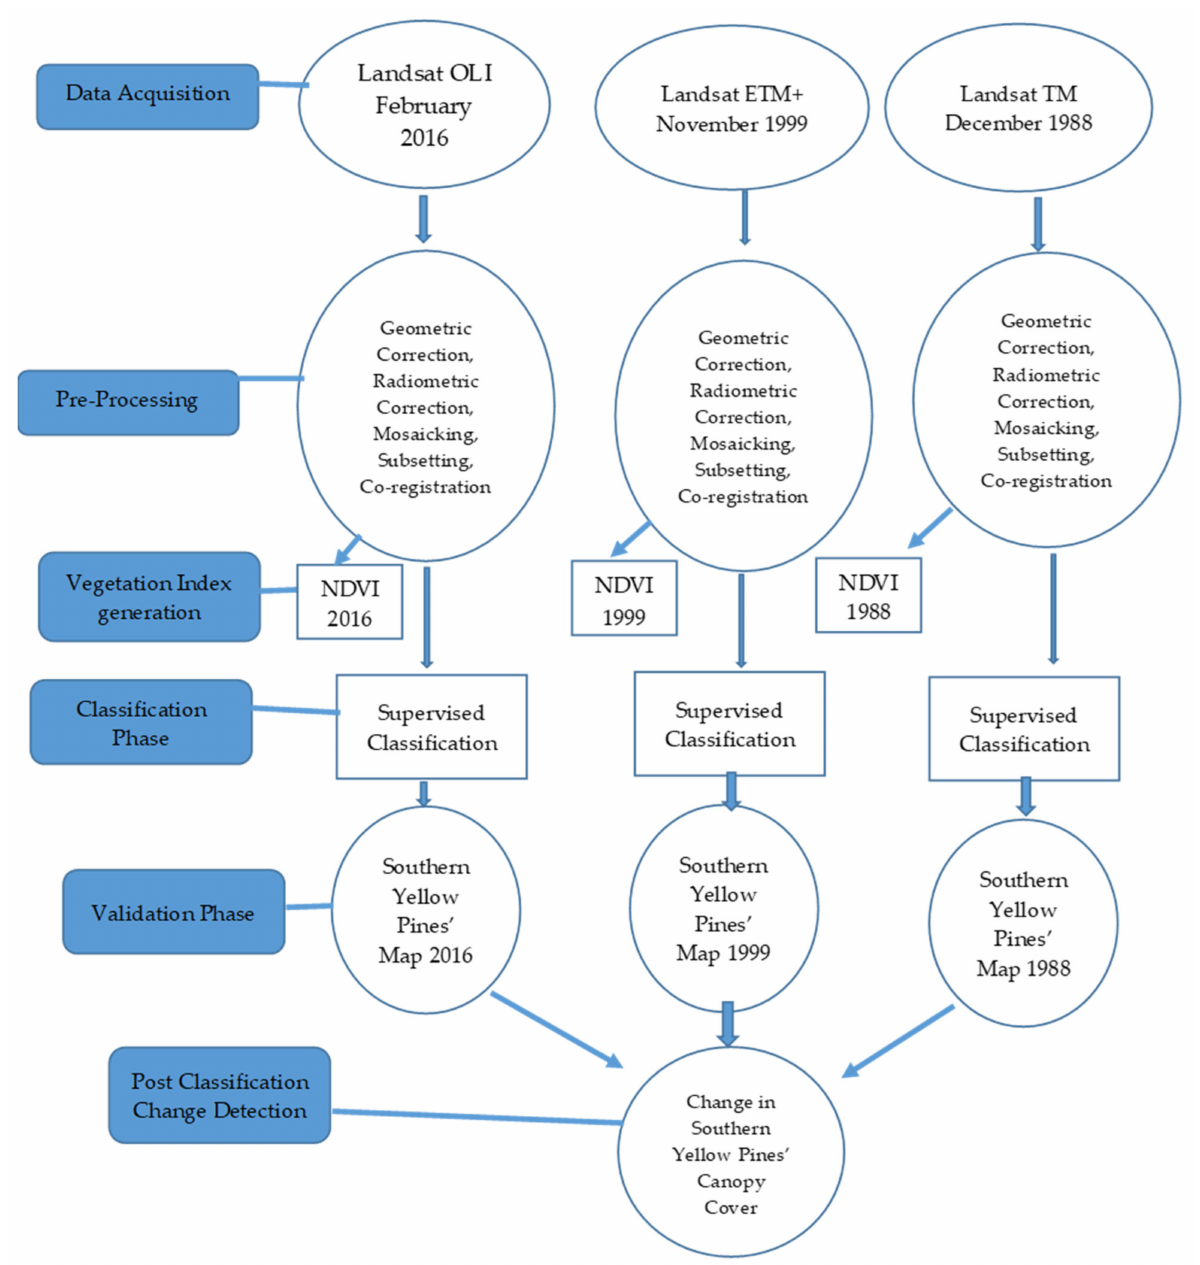
Figure 2. A graphical display of the methodological